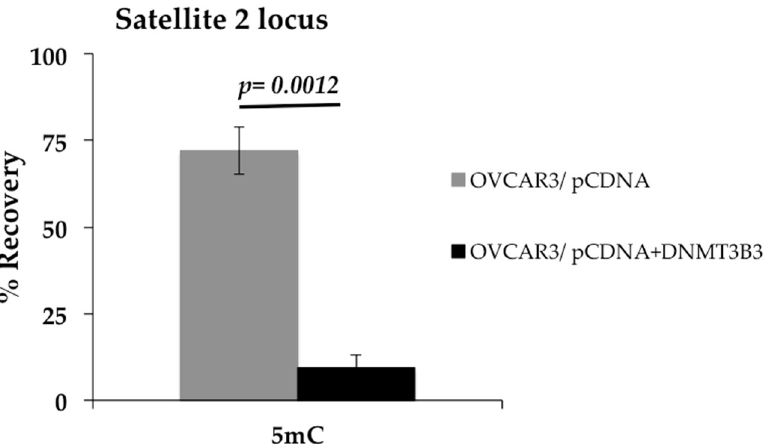
Figure 8. DNMT3B3 overexpression induces DNA hypomethylation in OVCAR3. Immunoprecipitation of 5 ′ methylcytosine was used to measure DNA methylation status in the satellite 2 locus: 15% of DNA methylation of the satellite 2 locus in OVCAR3 was detected after transfection of DNMT3B3. Mann–Whitney U test was used.